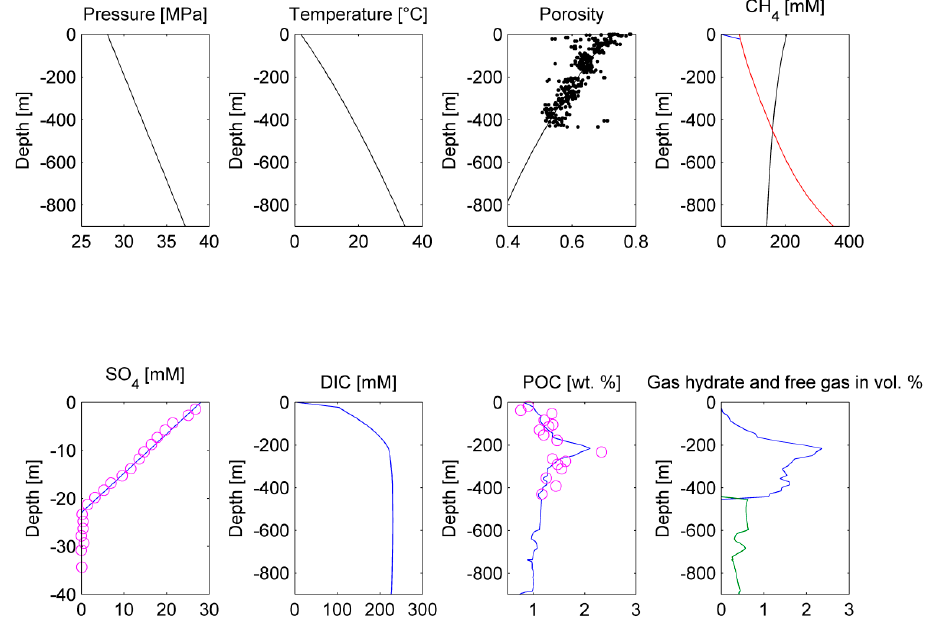
Figure 7. Modeling results of the Scenario 3. Upper panel, from the left: Pressure, temperature, porosity, and dissolved CH 4 concentration plots. Porosity measurements [20] are depicted as black dots, the modeling solution is represented by the black line. On the CH 4 concentration plot, red line depicts the phase boundary between gas hydrate and dissolved methane, black line represents the phase boundary between free gas and dissolved methane, blue line states dissolved methane